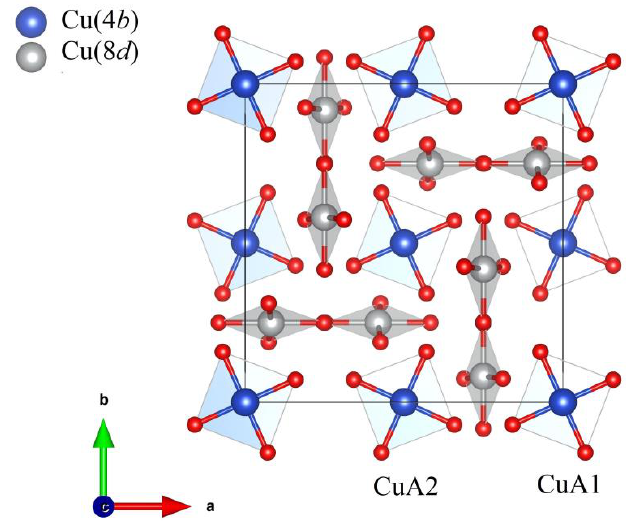
Figure 1. Projection of the CuO 4 units onto the ab plane of the tetragonal CuB 2 O 4 structure. Boron atoms are not shown. For the 4 b CuA1 (CuA2) positions, the local coordinate system is rotated counterclockwise by an angle ϕ = 20.9 ◦ ( − 20.9 ◦ ) around the tetragonal c axis, with respect to the crystallographic system. Thin black lines show the borders of the unit cell.